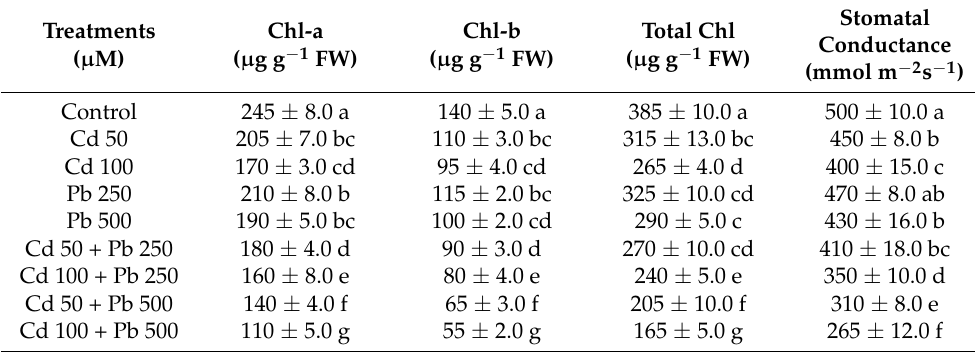
Table 2. Pigment contents and stomatal conductance of quinoa plants exposed to various concen- trations of cadmium and lead under hydroponic conditions.